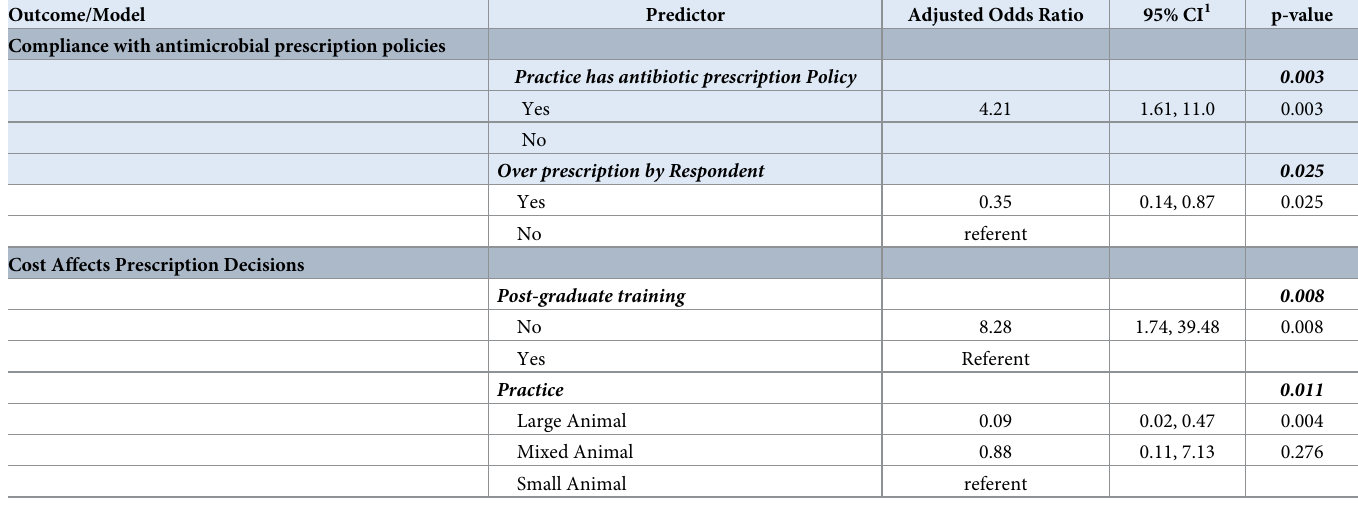
Table 5. Multivariable logistic model results showing predictors “compliance with antimicrobial prescription policies” and “cost of antimicrobial affects prescrip- tion decisions” among veterinarians in Kentucky, 2017. Outcome/Model Compliance with antimicrobial prescription